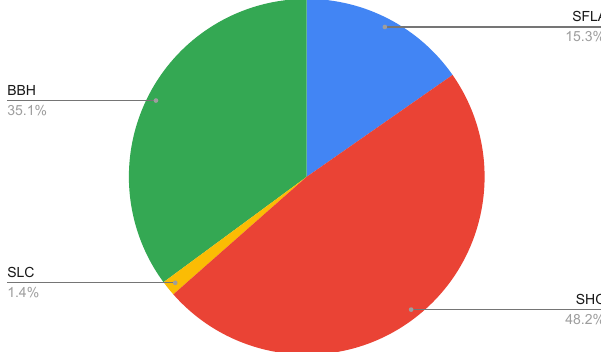
Figure 5. Average percentage of participation in the searching.